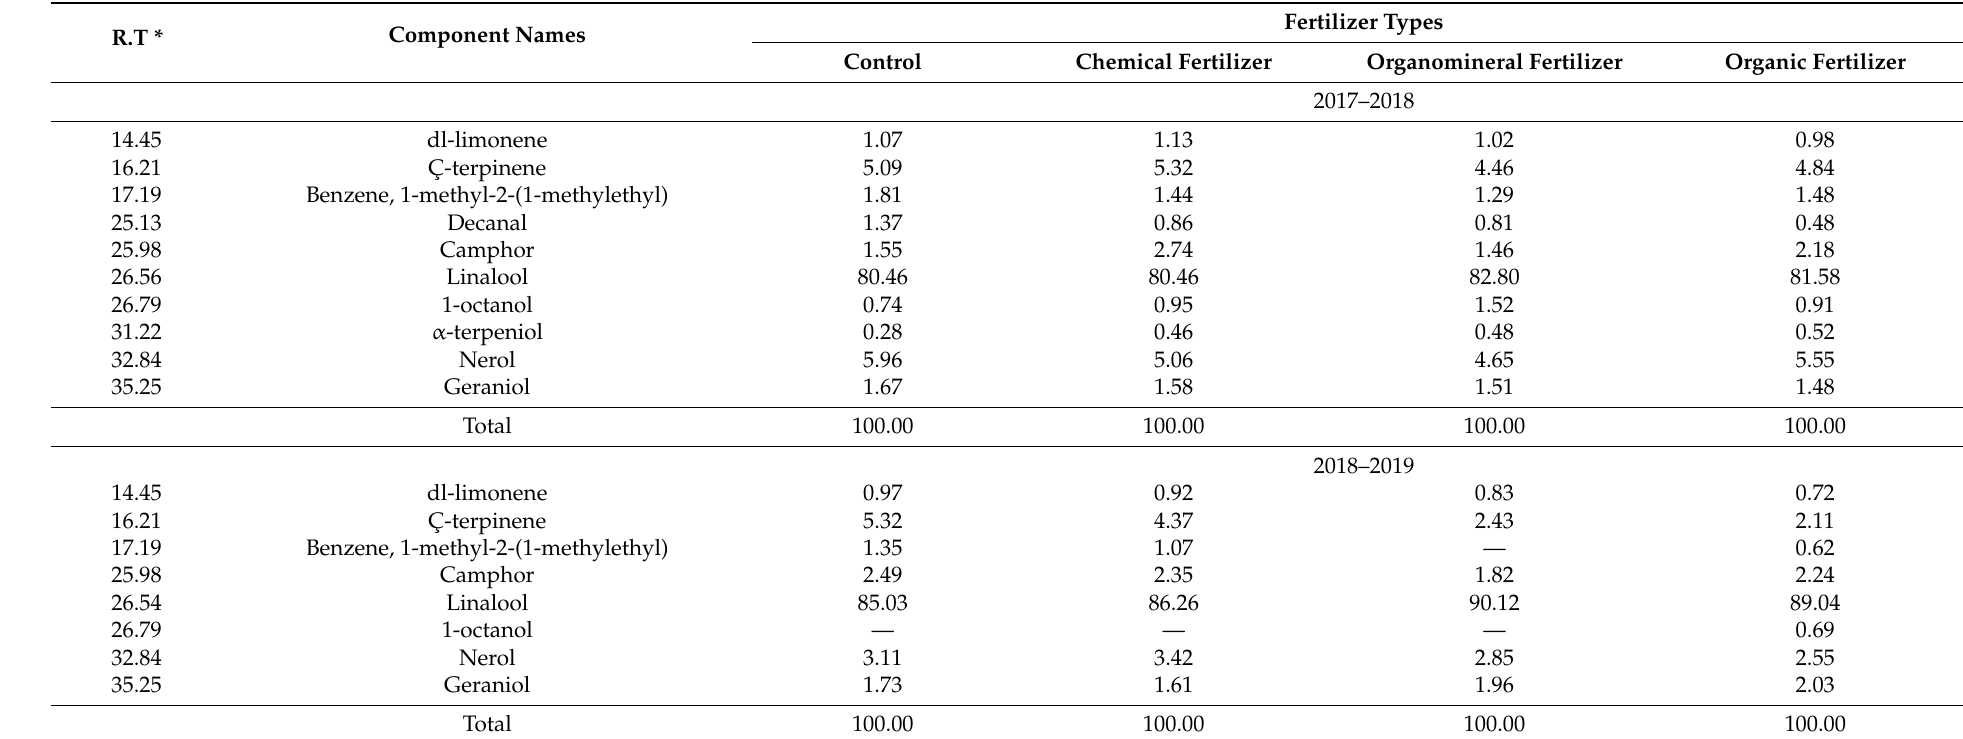
Table 12. Essential oil components of Erbaa coriander variety